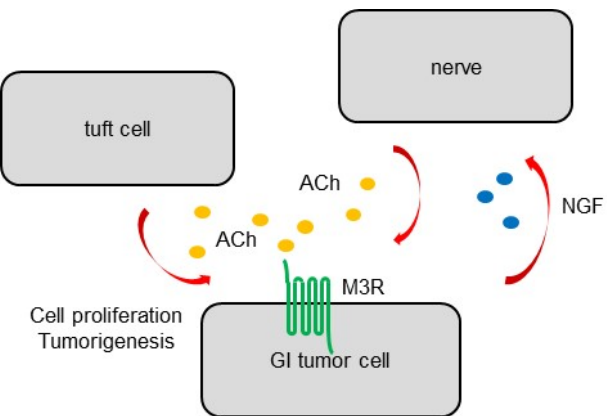
Figure 2. Schema of GI cancer cells and ACh sources. The nerve is the main source of ACh secretion. Dclk1 + tuft cells act as an alternative epithelial source of ACh. Nerves and tuft cells in the stomach and intestines expand at discrete times during carcinogenesis, leading to an increased ACh concentration in cancerous tissues. Cholinergic stimulation of the gastric epithelium induces nerve growth factor (NGF) expression, and, in turn, NGF overexpression in the gastric epithelium expands enteric nerves and promotes carcinogenesis.